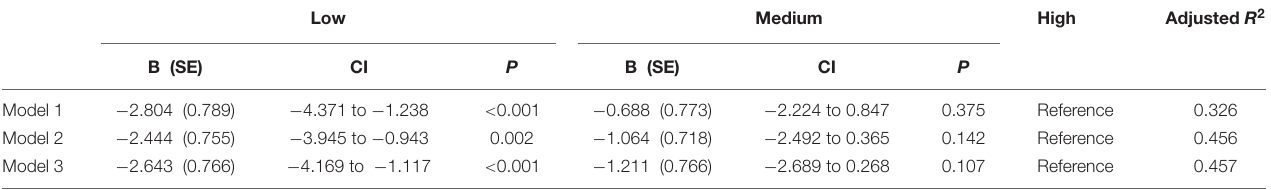
TABLE 3 | The results of multiple linear regression analyses assessing the associations between the serum copper strata and MMSE in non-demented older adults. Low Medium High Adjusted R 2